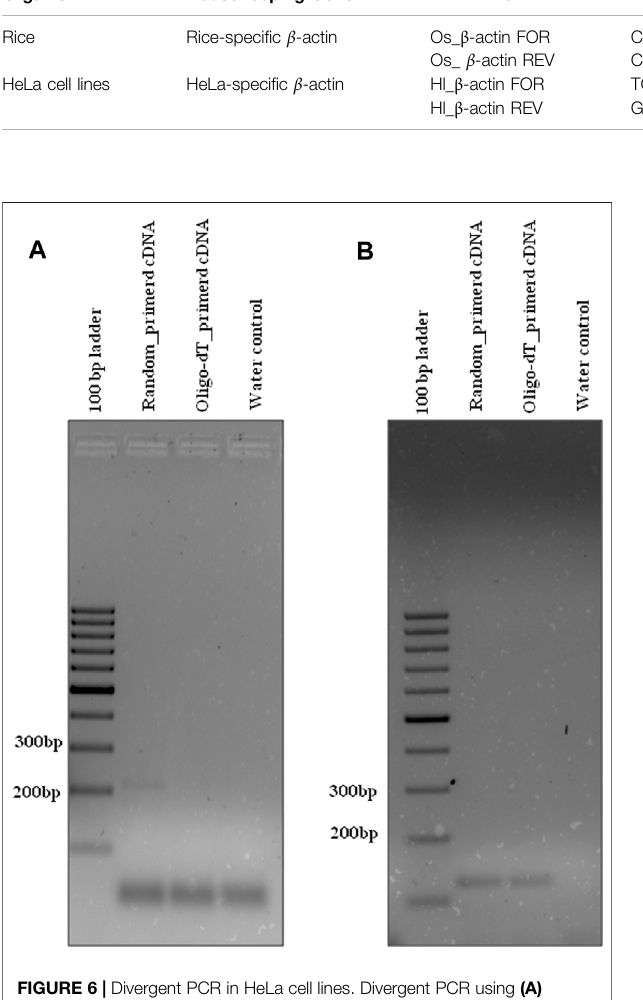
( Figure 6B ). The divergent PCR product was gel-eluted and Sanger- sequenced with the circRNA-speci fi c forward primer, which matched with the i-tdMDA-NGS-derived circRNA, hl_circ_19 – 8963380- 8964261_(-), sequence including the junction sequence (CC/CG) with an additional incorporation of T nt at its junction ( Supplementary Figure S11 ). Moreover, gel analysis of qRT-PCR data also showed the speci fi c ~267 bp amplicon in random-primed cDNAonlywiththe HL_DC_02primerandthe ~292 bpamplicon in both random-primed and oligo-dT derived cDNA (with human- speci fi c β -actin primer) apart from primer dimer ampli fi cation in triplicates ( Supplementary Figures S12C – E ), which explains the presence of an additional peak in the dissociation curve ( Supplementary Figures S12F – H ) and a corresponding Ct value for each sample ( Supplementary Figures S12A,B ).